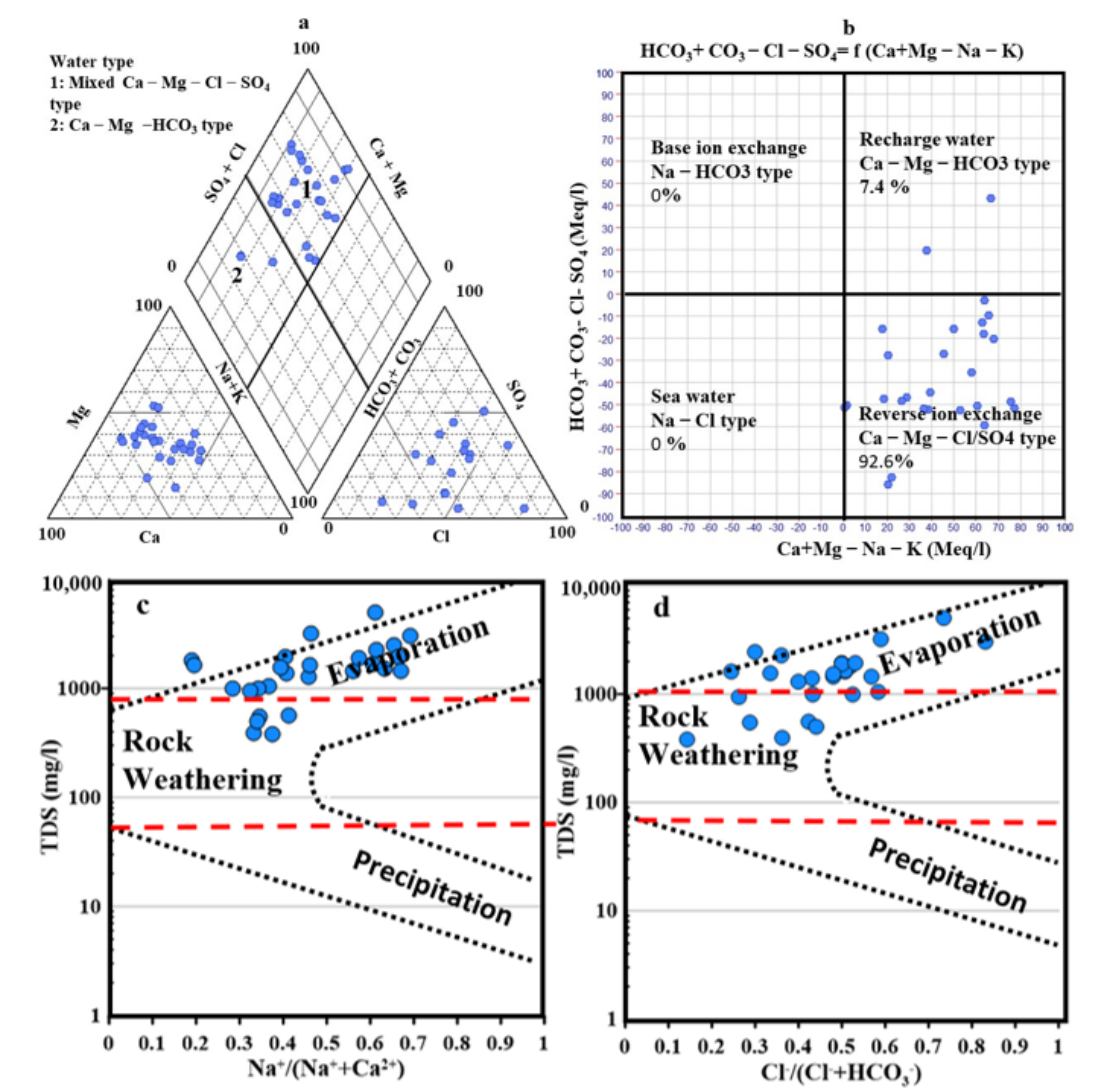
Figure 9. Plo tt ing water samples on piper diagram ( a ), Chadha diagram ( b ), ( c , d ) Gibbs